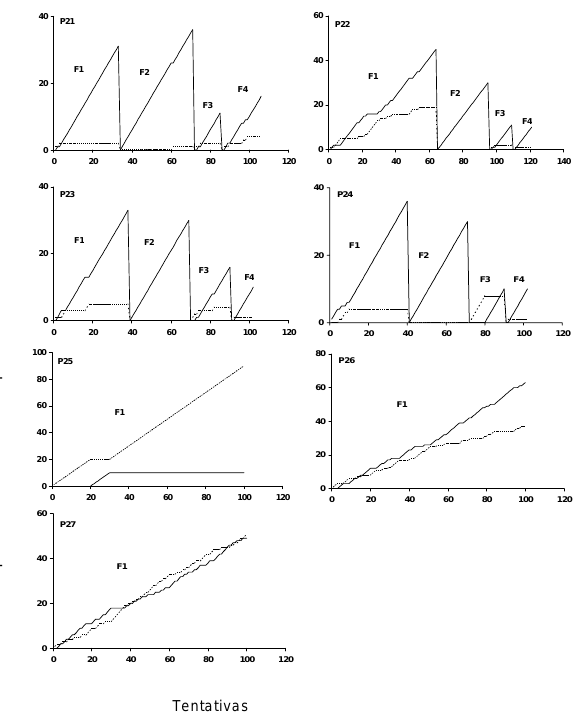
Figura 2 . Freqüência acumulada de respostas corretas (linha sólida) e incorretas (linha tracejada), para cada participante (P) da Condição 2, durante cada fase (F) experimental. Quebras na curva acumulada indicam mudanças de